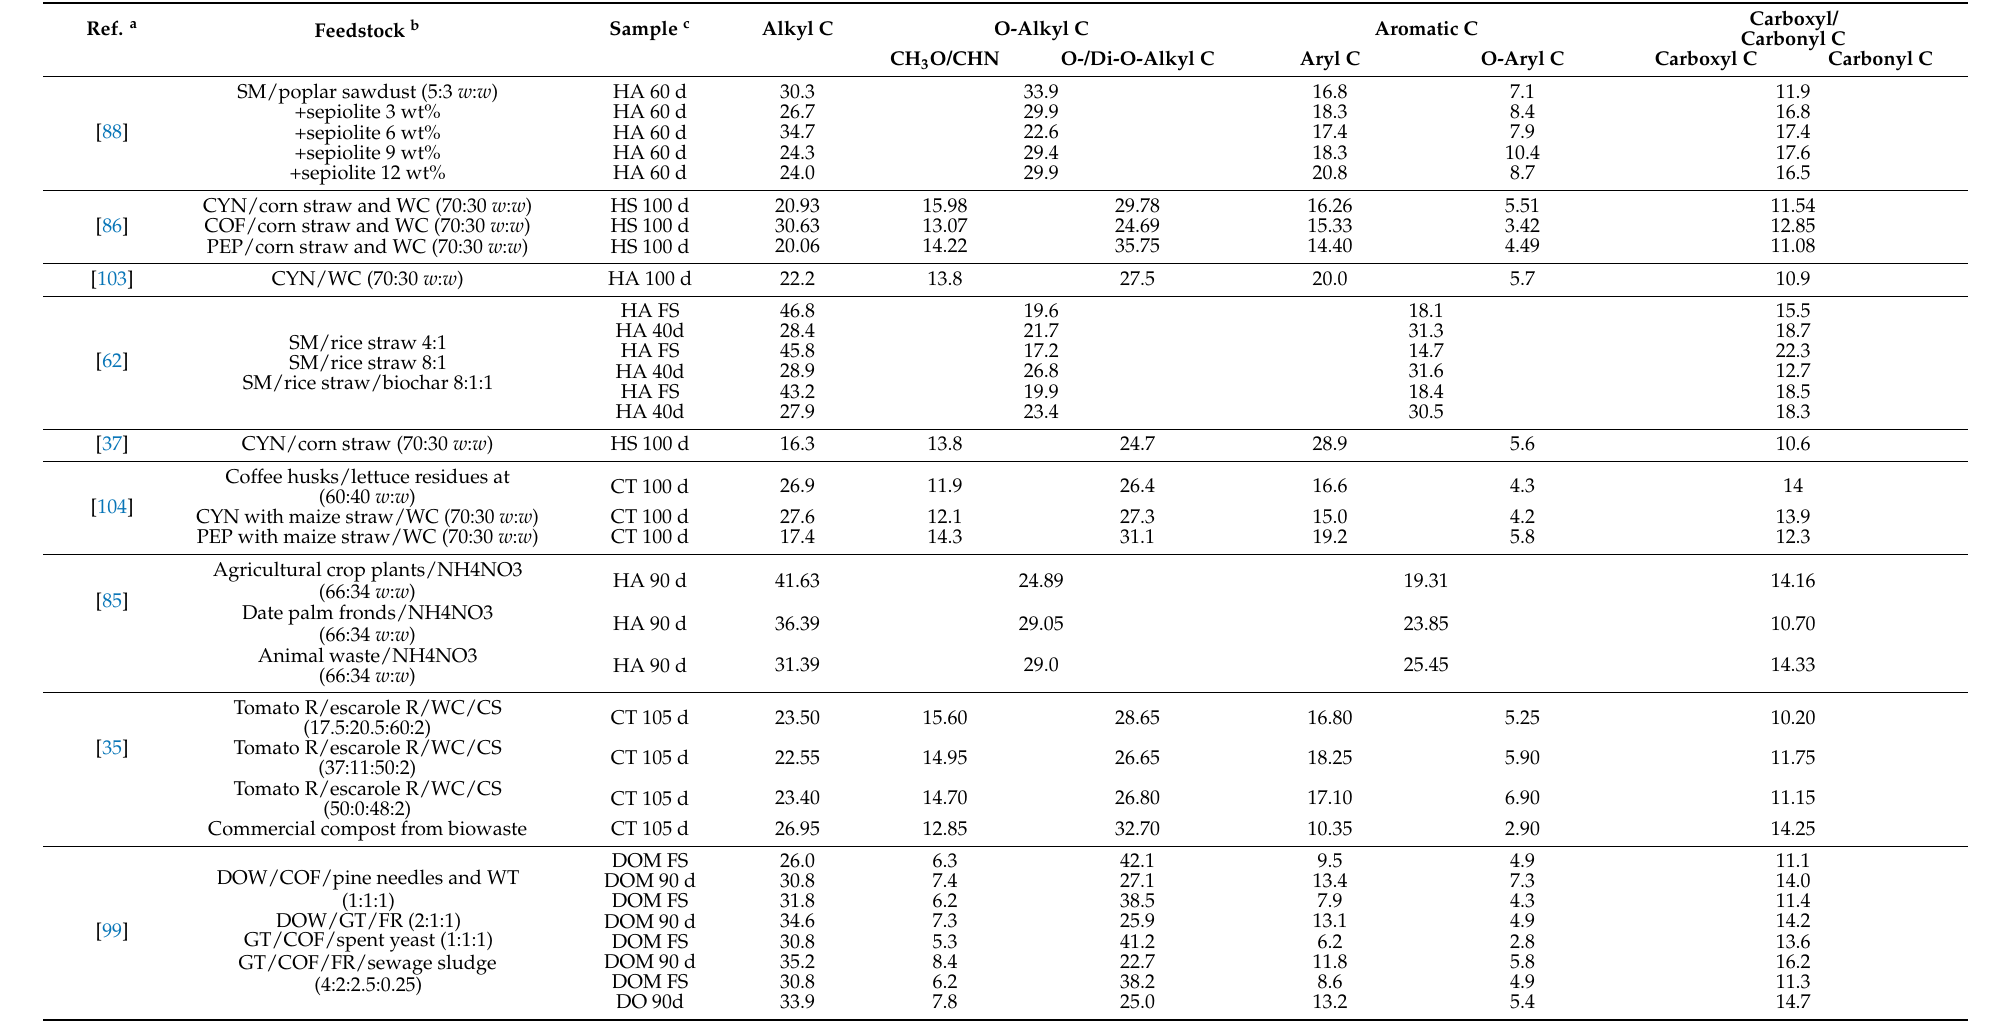
Table 3. Relative areas (% of total area) of the different regions of 13 C CP-MAS NMR spectra for extracts of composts and corresponding feedstocks reported in the